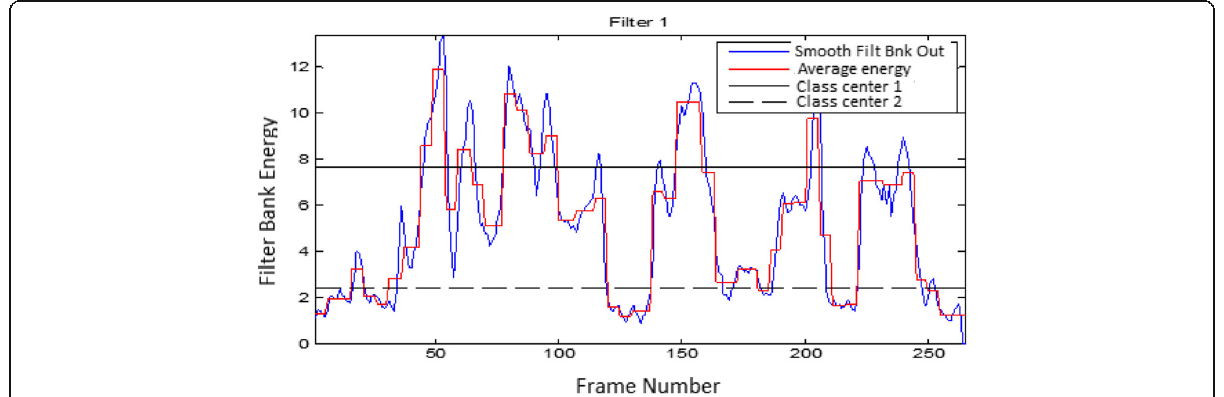
Fig. 2 Results of the regression and the k-means in filter 1